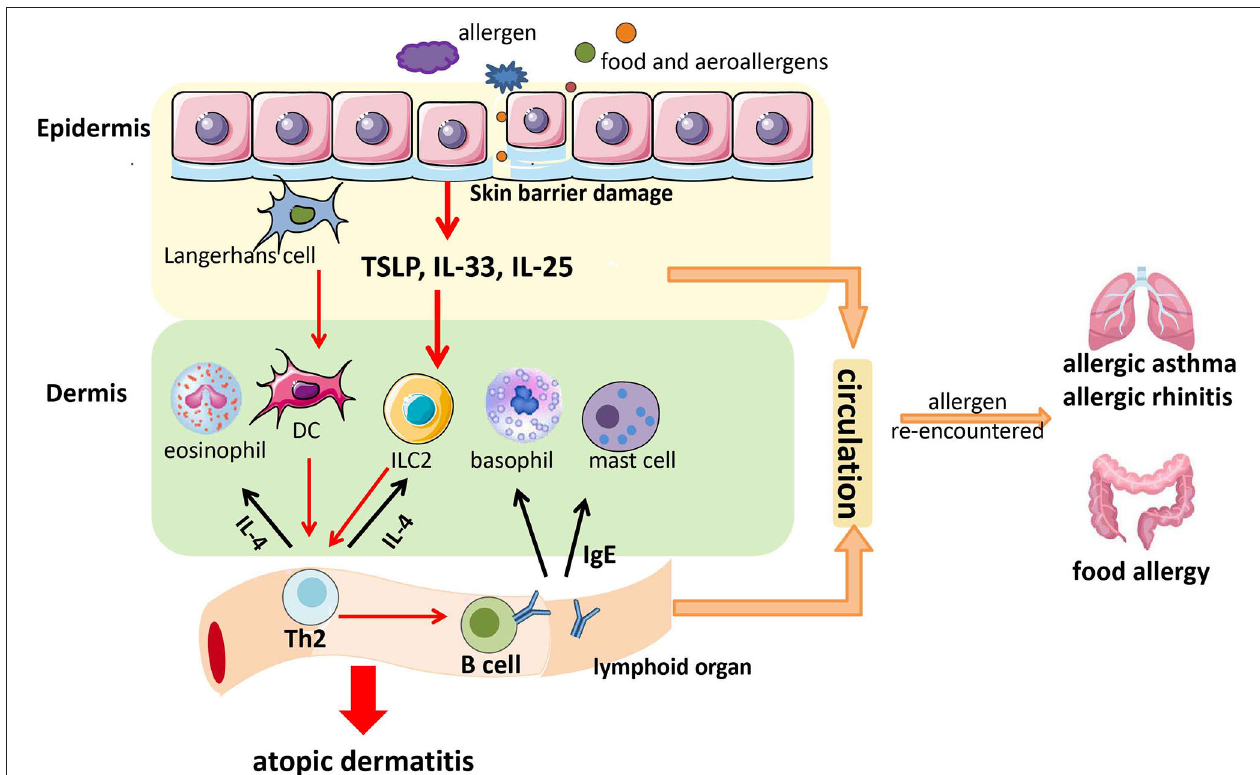
FIGURE 1 | A possible model of the contribution of skin barrier dysfunction to the atopic march. Allergens (including food allergens and aeroallergens) enter the skin through the damaged skin barrier. Then, they stimulate epithelial cells in the skin to release thymic stromal lymphopoietin (TSLP), interleukin (IL)-25, and IL-33. This action activates some immune cells in the dermis (e.g., basophils, mast cells, DCs, eosinophils, and ILC2) to secrete cytokines, followed by the generation of T-helper type 2 (Th2) cells and immunoglobulin E (IgE) production in local lymph nodes. Th2 cells can secrete more type 2 cytokines (e.g., IL-4) to activate more ILC2 and eosinophils, and IgE can act on mast cells and basophils. This positive feedback causes skin inflammation and atopic dermatitis (AD). Furthermore, IgE, Th2 cells, TSLP, IL-25, and IL-33 might enter the digestive tract and respiratory tract through blood circulation to facilitate the development of allergic asthma (AA), allergic rhinitis (AR), and food allergy if allergens are